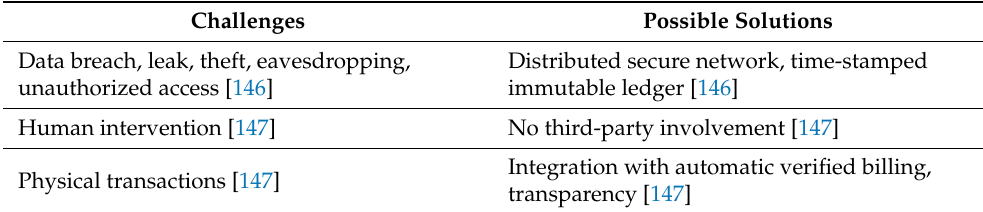
Table 6. Blockchain for Manufacturing